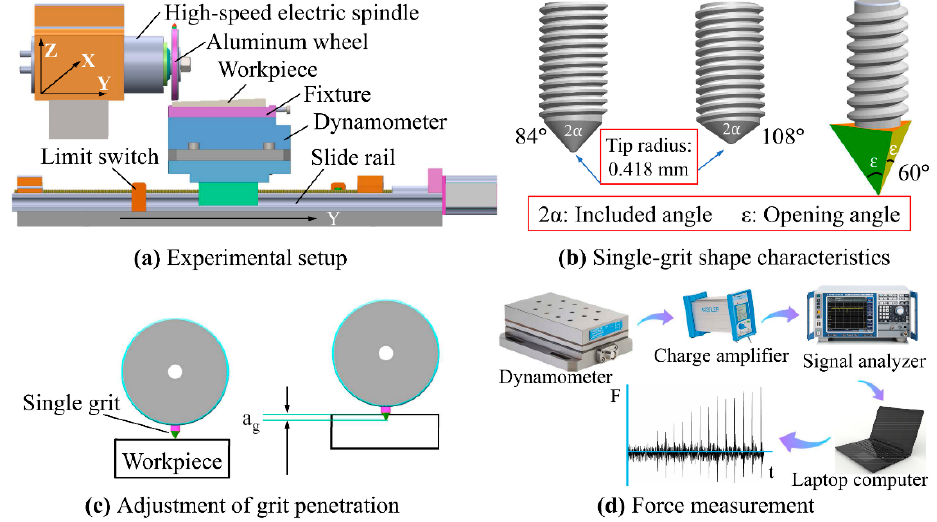
Figure 1. The single-grit scratch testing system: ( a ) experimental setup; ( b ) single-grit shape characteristics; ( c ) adjustment of grit penetration, and ( d ) force